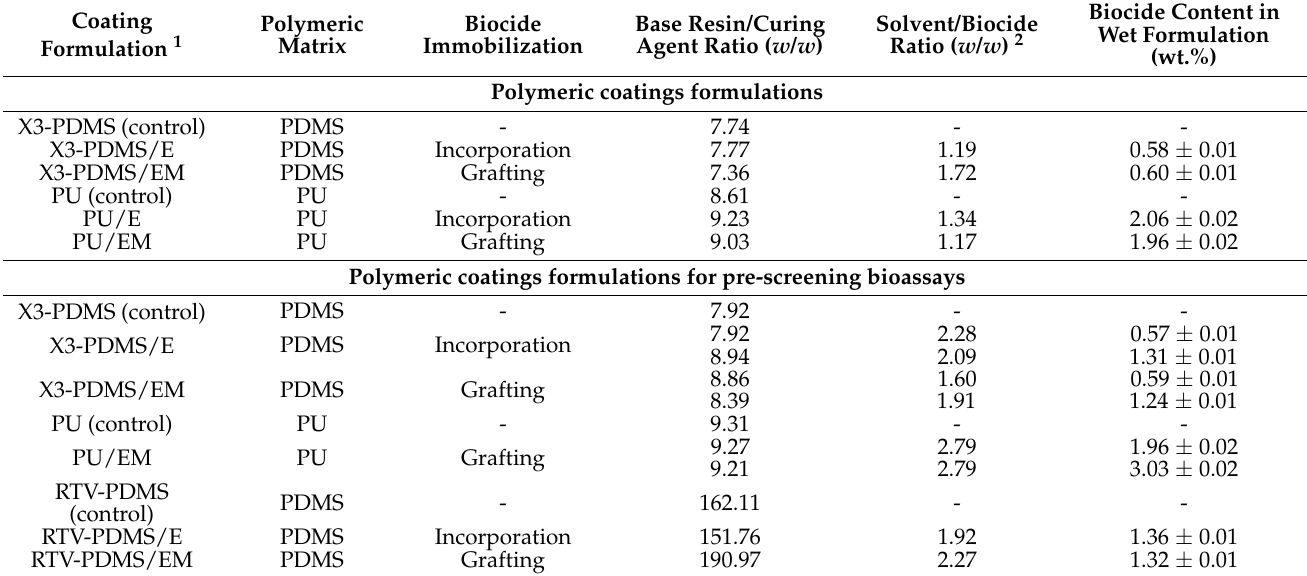
Table 1. Polymeric coating formulations containing either incorporated or grafted Econea biocide, and the respective pristine coating’s controls (free of